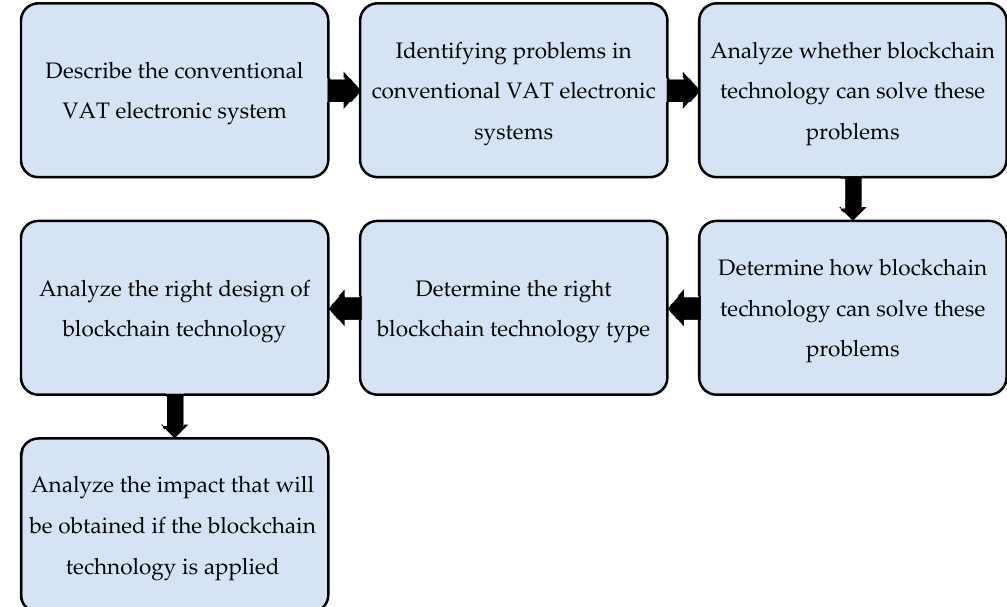
Figure 1. Scheme of the research analysis stages.